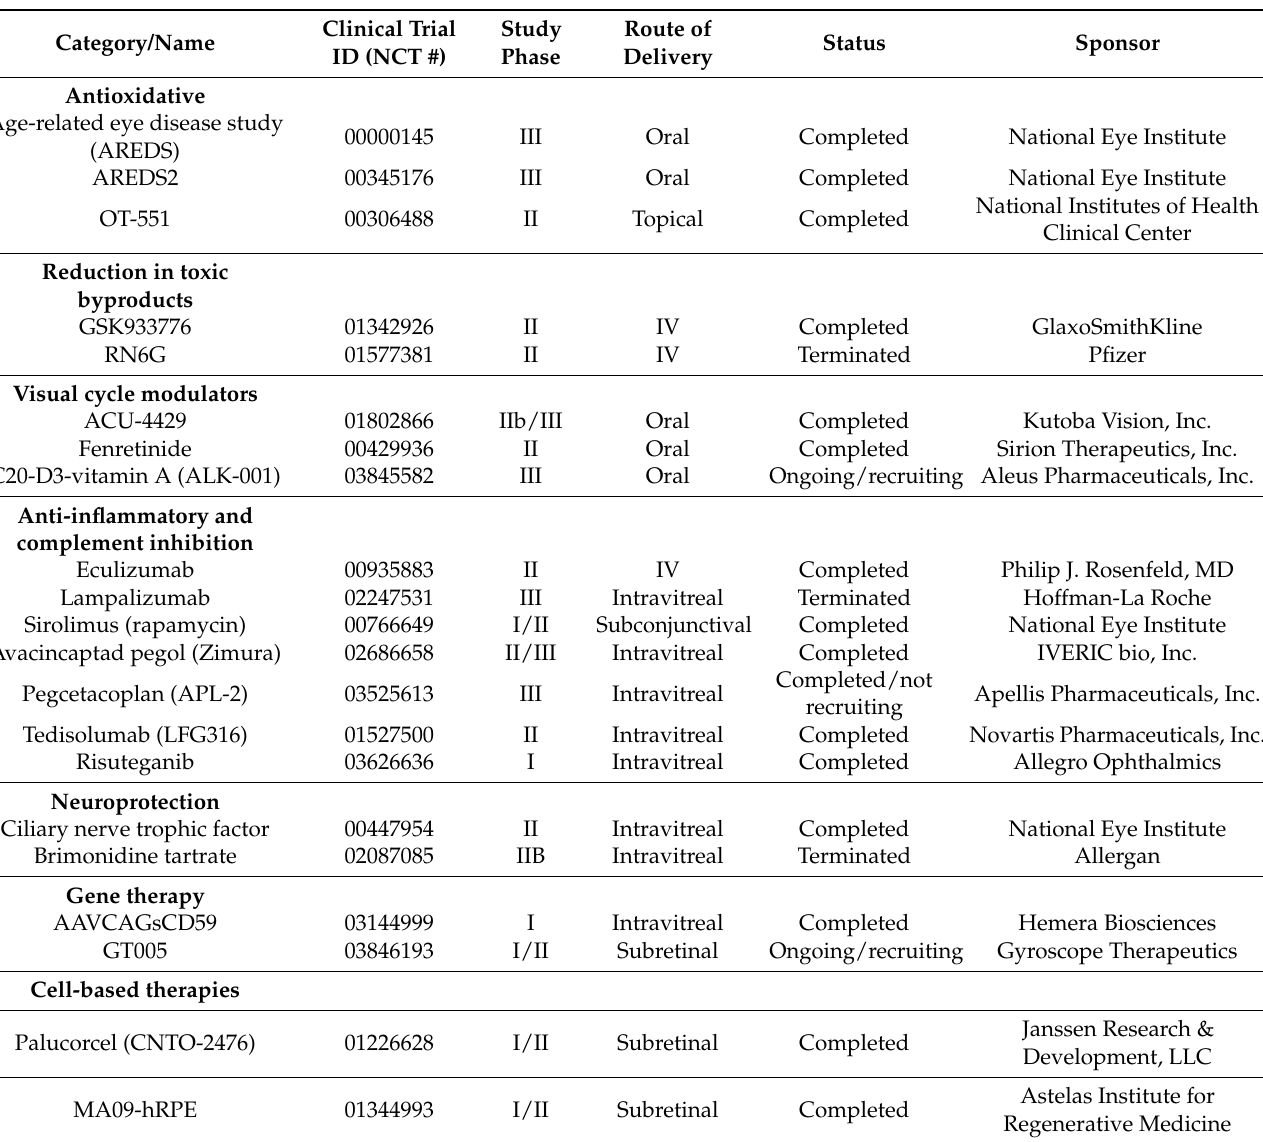
Table 2. Ongoing clinical trials for early (dry) AMD